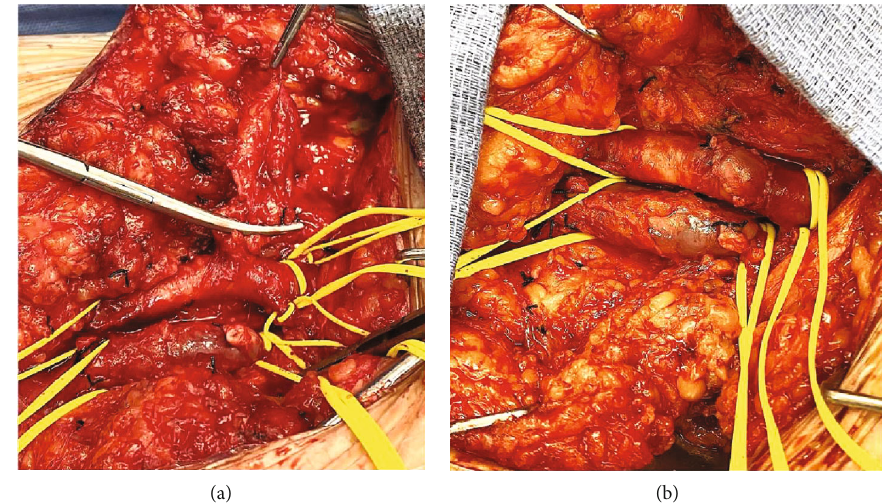
Figure 4: Repair of the AV fi stula with pseudoaneurysm. (a) Suture ligation of the venous limb of the structure with AV fi stula/ pseudoaneurysm remnant. (b) Repaired AV fi stula/pseudoaneurysm prior to closing. The common femoral artery is at the top with a great saphenous vein patch sewn in. The femoral vein is at the bottom with the stump